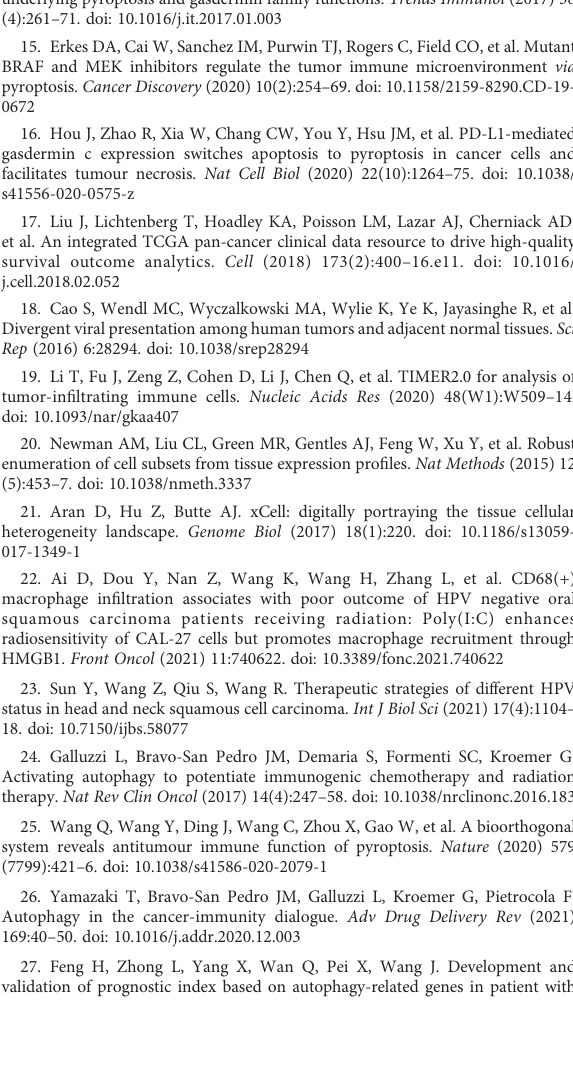
death index; HNSCC, head and neck squamous cell carcinoma; OS, overall survival; TNM, tumor-node-metastasis. SUPPLEMENTARY FIGURE 5 Association of CDI with survival bene fi ts of radiation and immune landscape in HPV positive HNSCC patients. (A) Kaplan-Meier survival curves illustrate the overall survival probabilities of HNSCC patients with different CDI scores receiving chemoradiotherapy, radiotherapy alone or neither of them in HPVpositive HNSCC patients (* P < 0.05, log-rank test). (B) Boxplots illustrate the immune scores and the microenvironment scores of high and low CDI subgroups in HPV positive HNSCC assessed using XCELL. (C) Boxplots of relative proportions of in fi ltrating immune cells in high and low CDI subgroups in HPV positive HNSCC assessed using CIBERSORT. (D) Boxplots of the expressions of immune checkpoint genes in different CDI subgroups in HPV positive HNSCC. The statistical signi fi cance is assessed by Wilcoxon test. * P < 0.05, ** P < 0.01. HNSCC, head and neck squamous cell carcinoma; CDI, cell death index; HPV, human papillomavirus; RT, radiotherapy; CT,